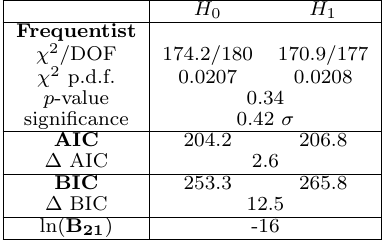
TABLE 4 Summary of model comparison results using frequentist, Bayesian and information theoretic criterion for H only) and H (model of background+cosine modulation with all parameters free). According to the frequentist model 1 comparison test, the χ 2 p.d.f (which represents the likelihood of the model given the data) for H the same as that for H hypothesis. The H hypothesis has smaller values for BIC and AIC. However, only the difference 0 0 in BIC is greater than 10, and hence BIC decisively favors the null hypothesis according to the strength of evidence